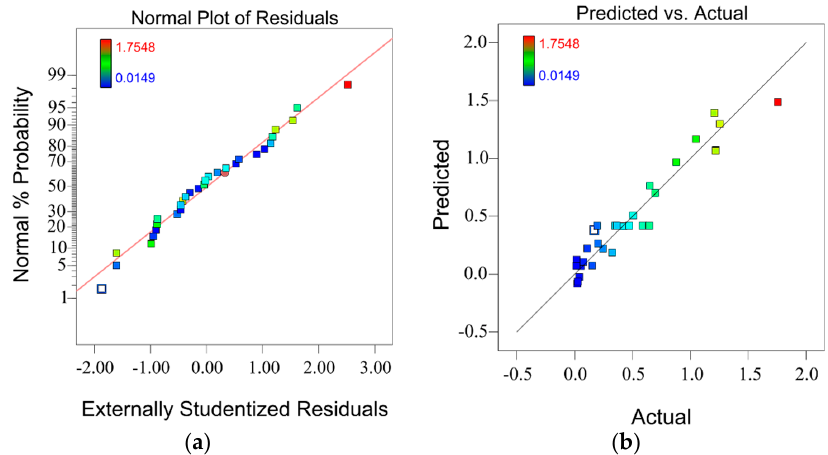
Figure 11. ( a ) Residual analysis of the defect area; ( b ) Defect area comparison between the predicted and the actual.